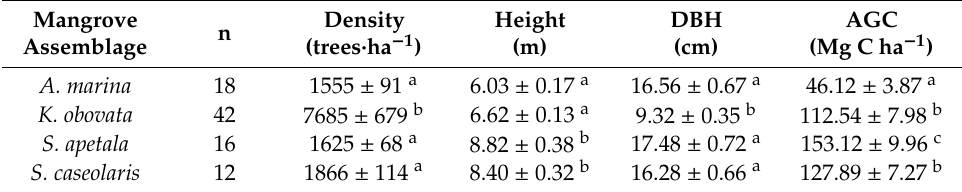
Table 2. Summary of the mangrove species information from the field